Question: Does the figure show an increasing or a decreasing trend?
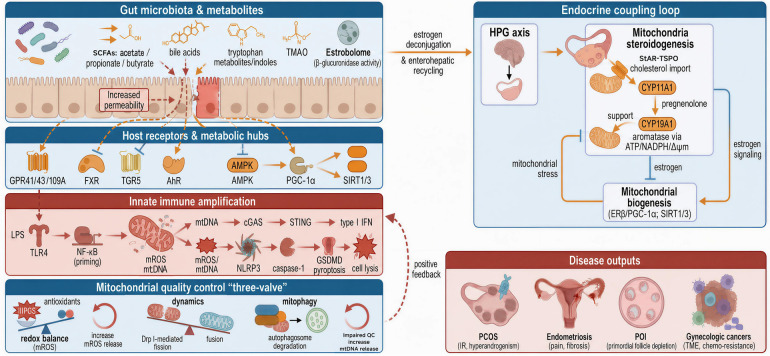
Answer: increasing